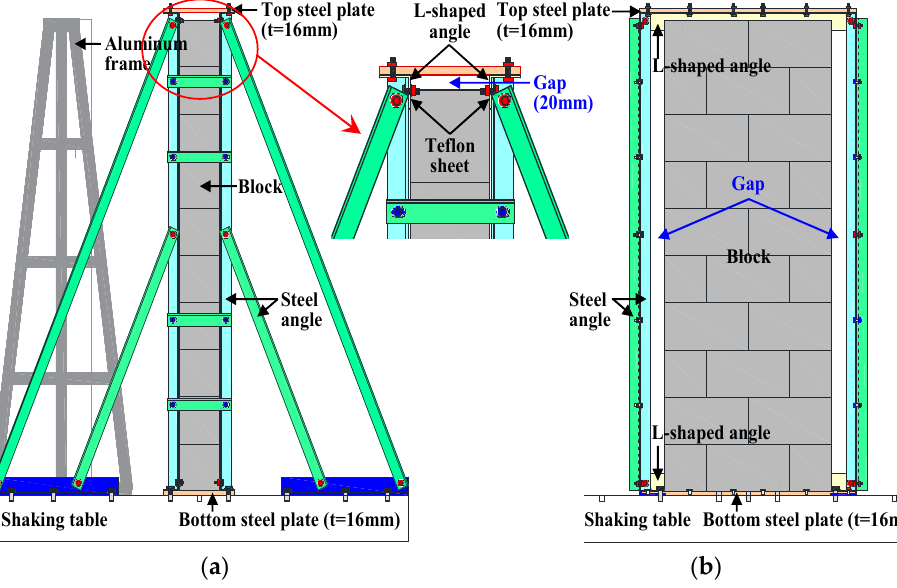
Figure 7. Shaking table test setup: ( a ) side view; ( b ) elevation view.